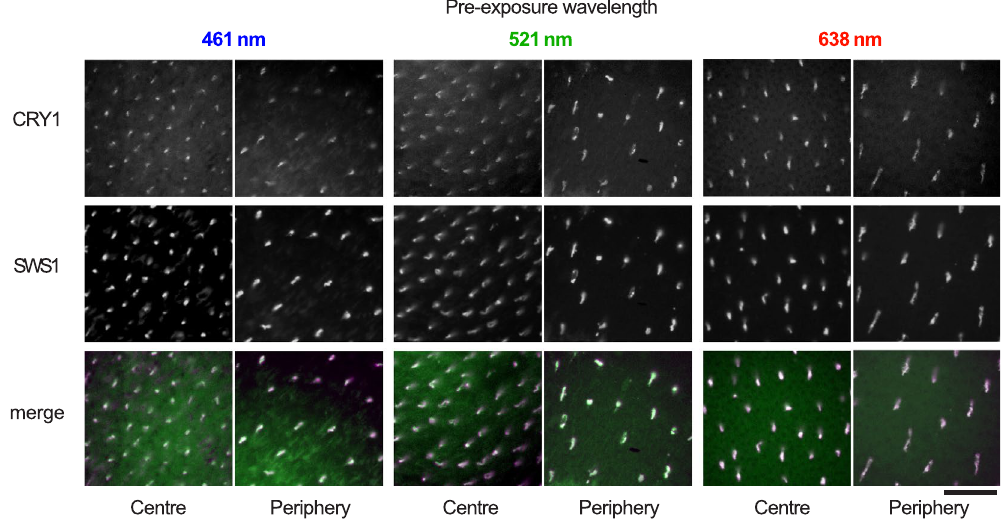
Figure 6. Colocalisation of CRY1 and SWS1 in retinas of zebra finches exposed to monochromatic illumination. The upper row shows CRY1-positive cones, the middle row SWS1-positive cells, and the bottom row shows the merged images (CRY1 in green, SWS1 in purple and colocalisation is seen as white). The panels illustrate examples from birds exposed to 461 nm blue light (left), 521 nm green light (centre) and 638 nm red light (right). For each wavelength spectrum, an example from the central retina and one from the peripheral retina is shown. Bar: 30